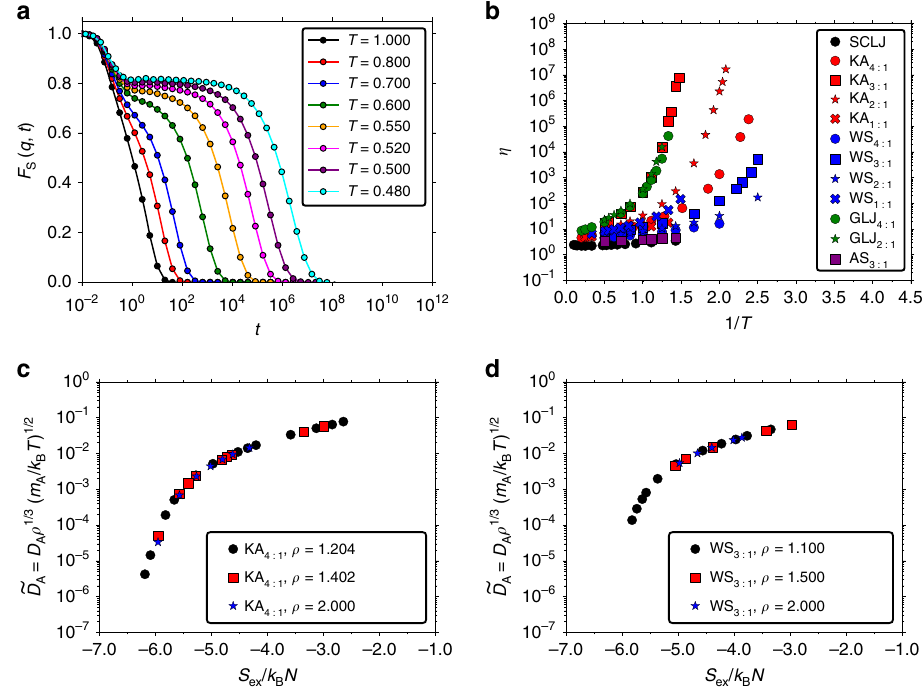
Fig. 1 Supercooled dynamics and excess-entropy scaling. a Temperature dependence of the self-part of the ISF for the 2:1 KA mixture ( ρ = 1.400). The mode-coupling temperature is T MCT = 0.55. b The viscosity η as a function of 1/ T for all mixtures. Signi fi cant non-Arrhenius temperature dependence is observed for all systems. The KAEXP and CuZr mixtures are omitted due to their different temperature scales (they show a similar behavior). The studied densities are given in “ Methods ” . c Excess-entropy scaling for diffusion coef fi cient for the 4:1 KA mixture at the densities: ρ = 1.204, 1.402, 2.000. d Excess-entropy scaling for diffusion coef fi cient for the 3:1 WS mixture at the densities: ρ = 1.100, 1.500, 2.000. An excellent collapse is found for both systems, consistent with the isomorph-theory predictions 44 .